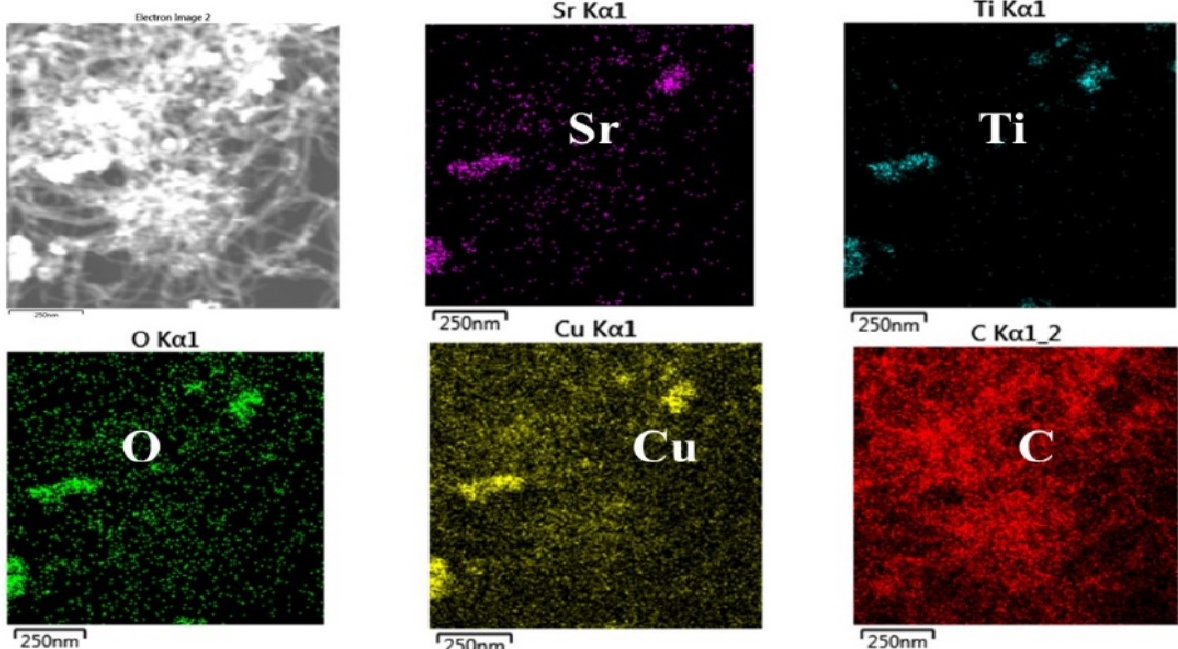
Figure 14. DF-STEM-EDX mapping of the recycled 5% CuO/STO/MWCNTs nanocomposites. To evidence the photodegradation mechanism and the charge recombination, the PL analyses were performed. As shown in Figure 15, the PL intensity of the 5% CuO/STO/MWCNTs nanocomposites was lower than the pure STO. This suggests the ex- istence of a photogenerated electron transfer from STO to CuO, which efficiently reduces the recombination of photogenerated electrons and holes in 5% CuO/STO/MWCNTs nanocomposites. It further confirms that the increasing photocatalytic activity of 5% CuO/STO/MWCNTs nanocomposites is ascribed to a more effective charge separation and the interaction of CuO and STO [41].